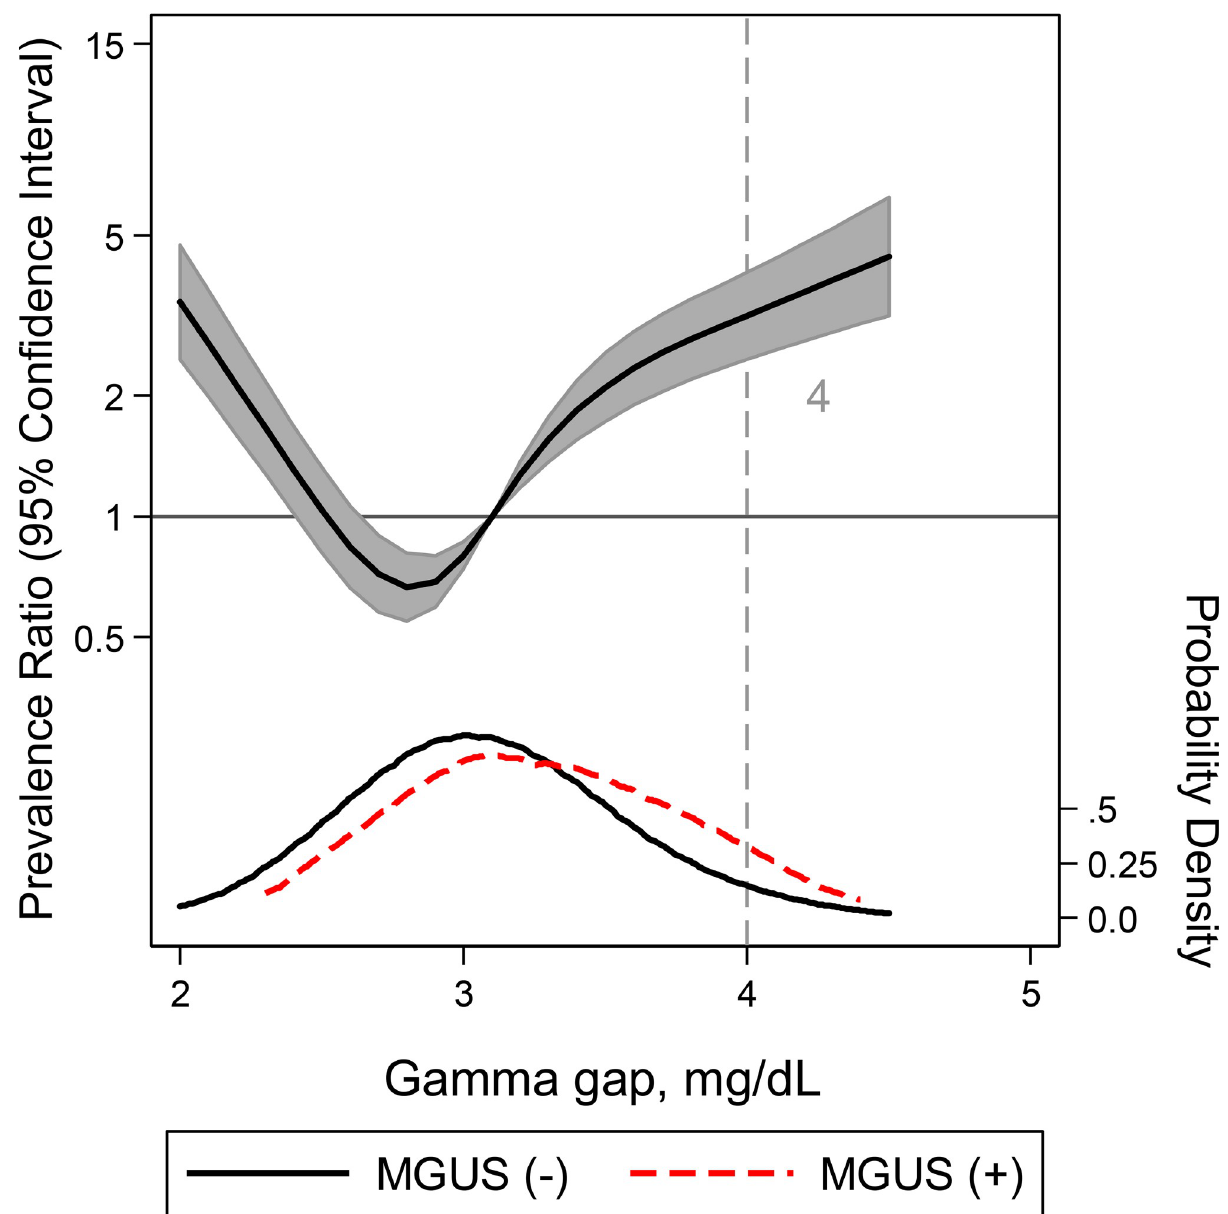
Fig 3. A restricted cubic spline model of the relationship between gamma gap and MGUS adjusted for age, gender, and race with three knots. Adjusted prevalence ratio (solid line) and 95% CI were plotted against the gamma gap. Plot was truncated at the 0.5th and 99.5th percentiles. Gamma gap distribution in the case (positive for MGUS) sample (red) compared to the control (negative for MGUS) sample (black) are also included. The vertical grey line at 4g/dL indicates the commonly used gamma gap